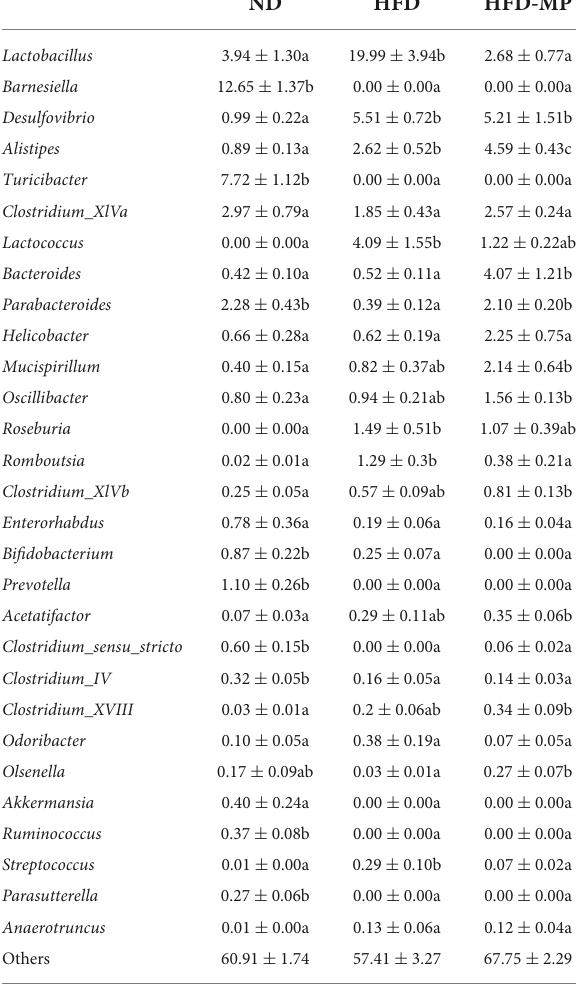
TABLE 1 Comparative analysis of the gut microbiota between the groups at the genus level. ND HFD